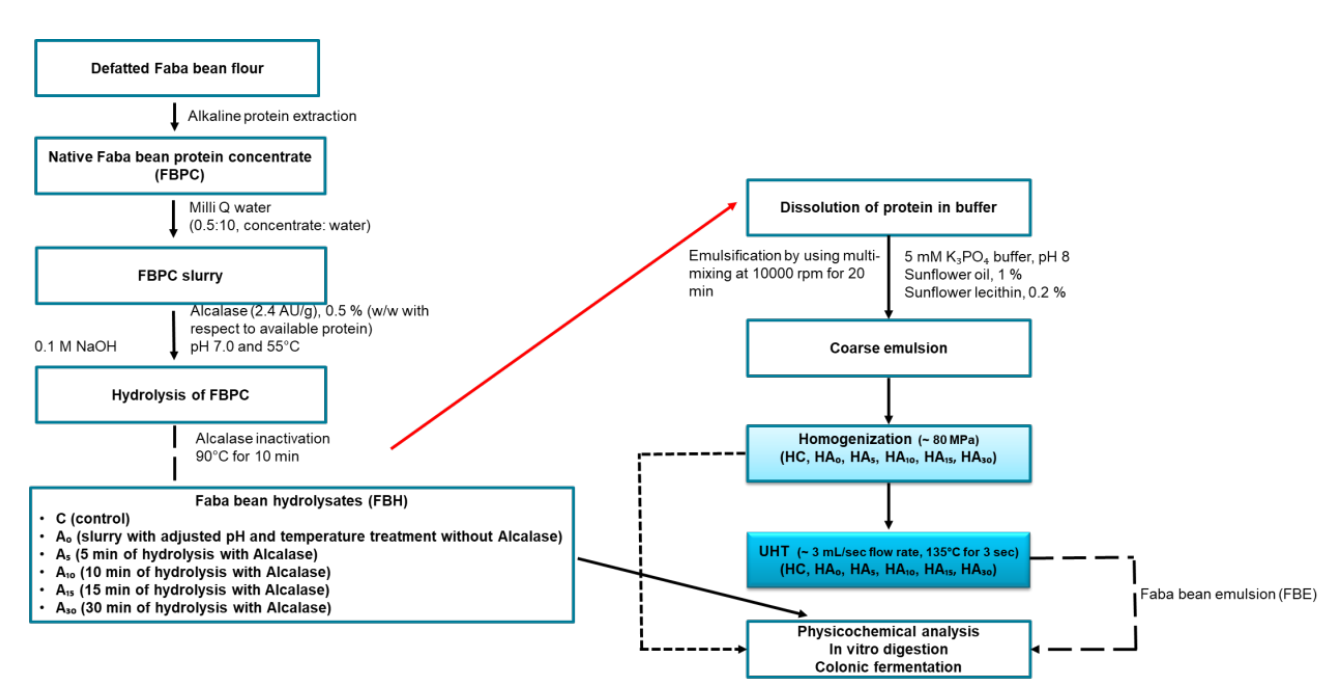
Figure 1. Experimental design.